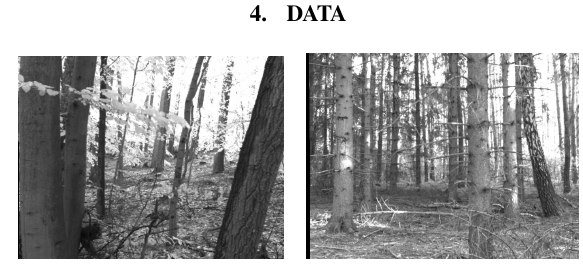
Figure 2. Exemplary greyscale images Greyscale images as exemplary depicted in figure 2 were used as input images. Figure 3 shows the results of the stereo vision based image segmentation algorithm used by VINS 3D red areas depicting trees and blue areas showing background.